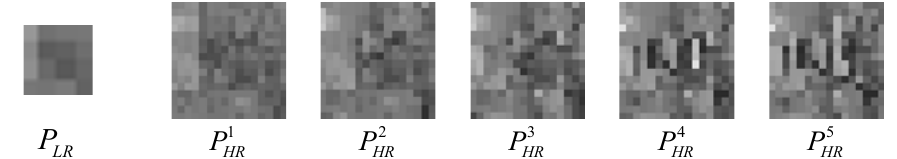
Figure 2. The one-to-many relationship between the low spatial-resolution (LR) patch and high spatial-resolution (HR) patches. The same LR patch can be produced by the HR patches with different geometric structures through the same spatial degradation model.